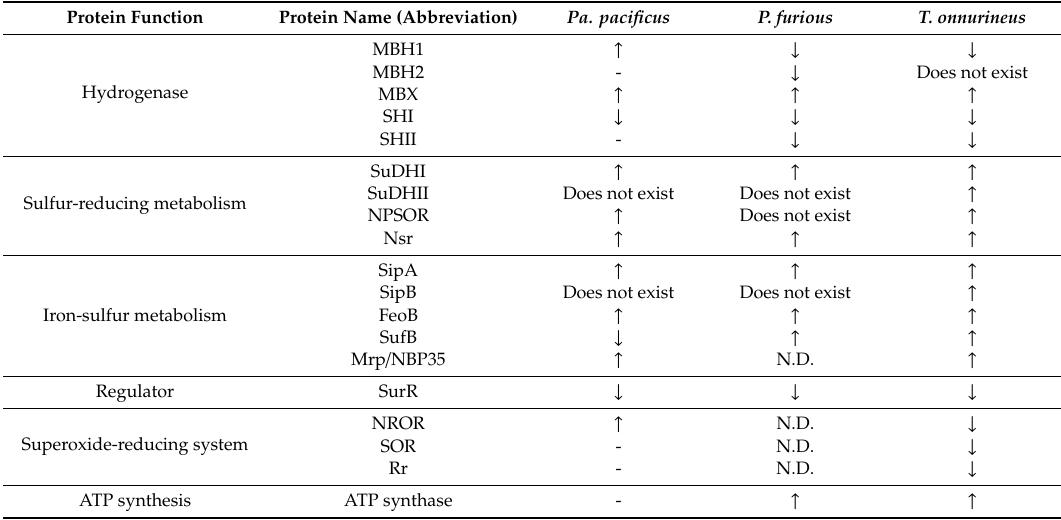
Table 2. The expression di ff erence of key genes in S 0 -reduction system between Thermococcales species. Protein